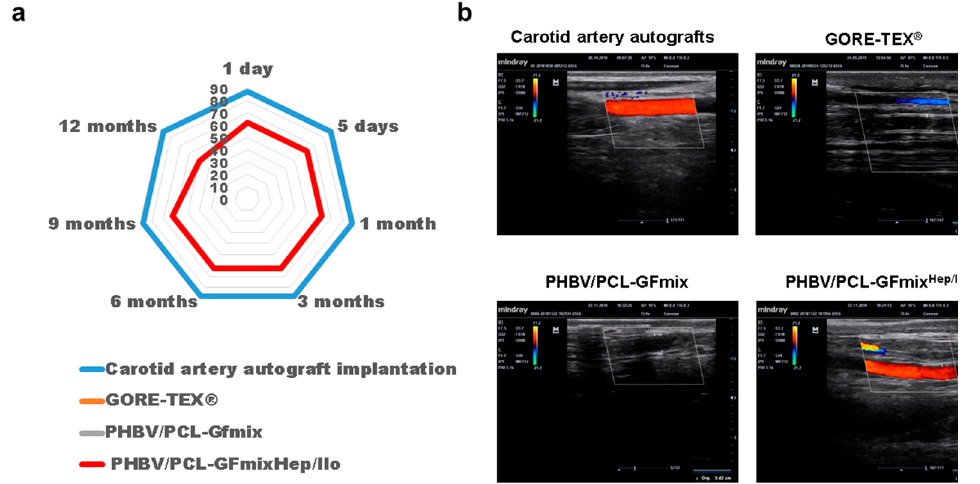
Figure 1. Ultrasonography studies of sheep implanted with experimental vascular grafts. ( a ) Patency of vascular grafts (%) at different timepoints following implantation into the carotid artery of sheep. Note that GORE-TEX ® and PHBV/PCL-GFmix are not shown because their patency was 0% during the entire study. ( b ) Representative ultrasonography images of sheep’ carotid arteries after graft implantation. Red areas indicate the blood flow.